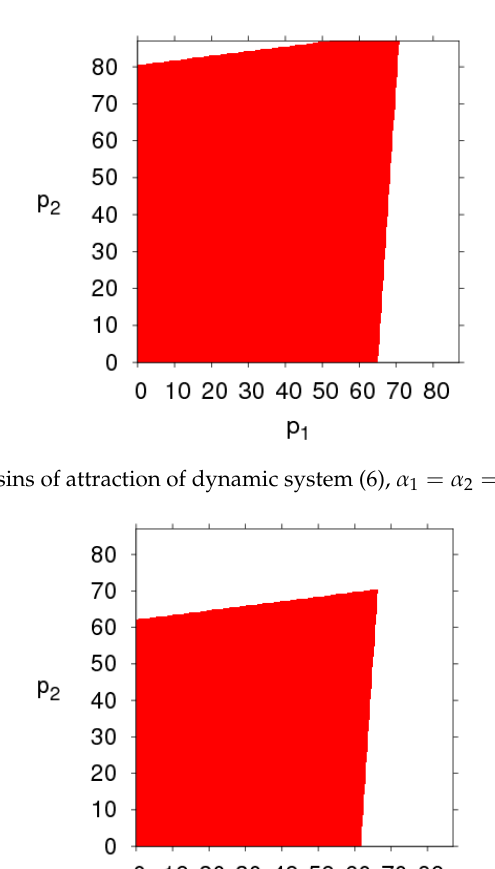
Figure 15. Basins of attraction of the dynamic system (6). (a) 𝛼 (cid:2869) = 𝛼 (cid:2870) = 0.005 , (b) 𝛼 (cid:2869) = 𝛼 (cid:2870) = 0.008, (c) 𝛼 (cid:2869) = 0.012, 𝛼 (cid:2870) = 0.008 .